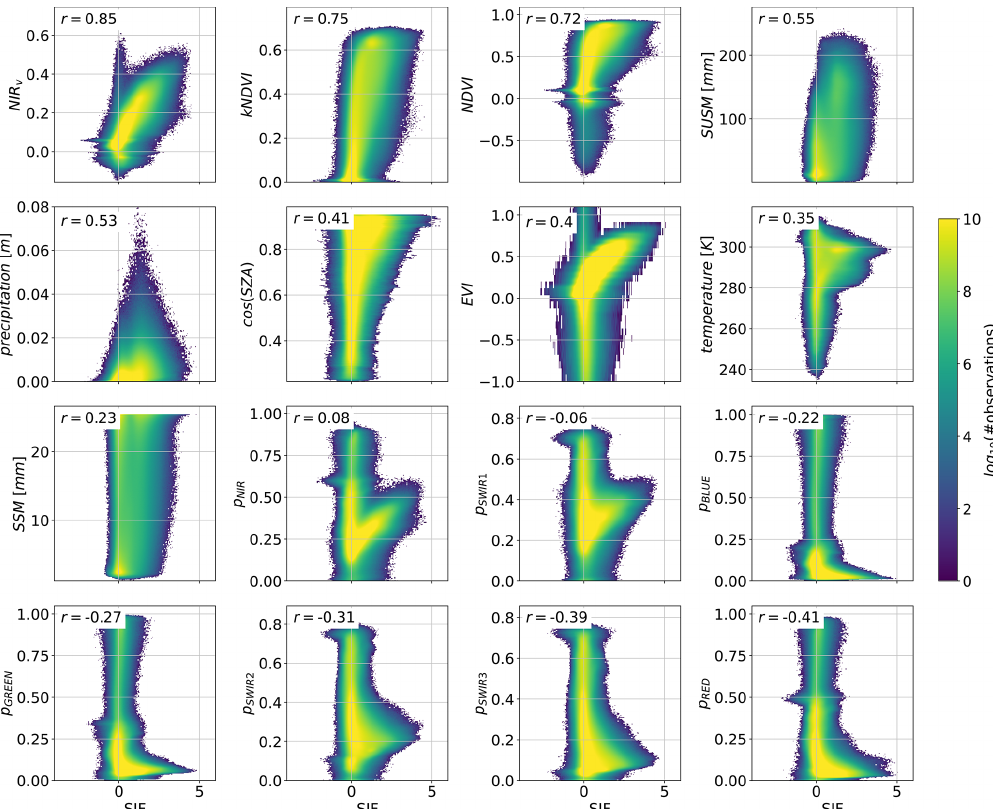
Figure 1. Scatter comparison of SIF to timely changing auxiliary data. The time span of measurements is from April 2018 to March 2021 at 16d resolution. Longitude and latitude borders are from − 180 to 180 ◦ and − 60 to 70 ◦ , respectively. The comparison resolution corresponds to the lowest resolution of the two corresponding products. For all MODIS data the resolution is 0.05 ◦ and for precipitation, air temperature, surface soil moisture (ssm), and subsurface soil moisture (susm) 0.1 ◦ . To quantify the goodness of fit we compute the Pearson correlation coefficient ( r ) for each subplot (Benesty et al.,